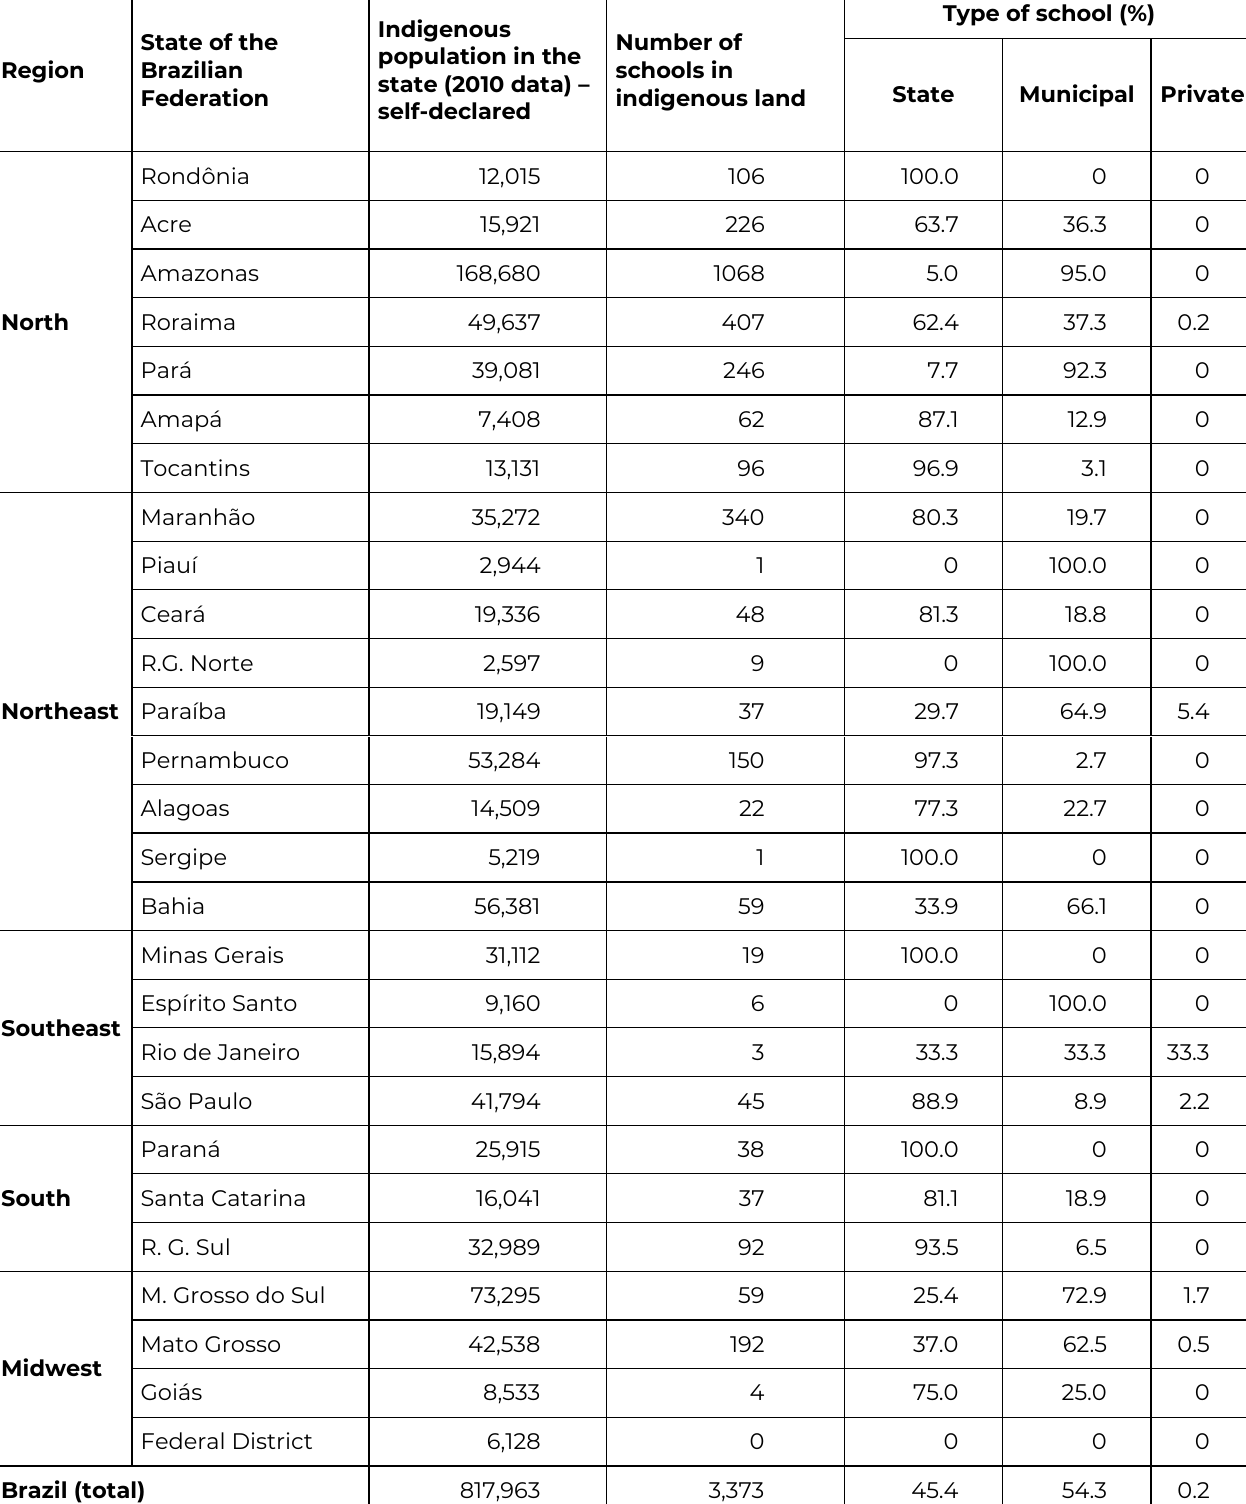
Table 2. Indigenous schools per Brazilian state, year 2019 State of Region